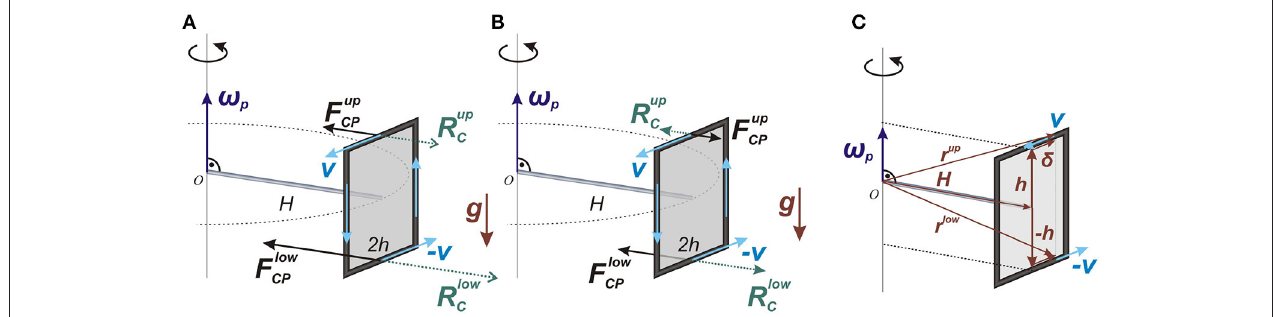
FIGURE 4 | (color online) Flat square wheel model of a heavy top in gravitational field with acceleration g , viewed from the laboratory (inertial) reference frame (see section 2.3). Absolute values of the chain/fluid velocities in the horizontal segments, with respect to the square wheel, are marked with blue. (A,B) Centripetal forces, F CP , acting on the fluid or chain in the middle of the horizontal segments marked by black continuous lines, reactive central forces, R C , acting on the corresponding support segments are marked by dotted green lines. Note that depending on the ratio of ω p and v , these can point in the same or in opposite directions (see also Supplementary Figure 1 ). (C) Sketch for the calculations of the torques raising in the symmetric points marked by r up and r low (see Equations 2, 3).